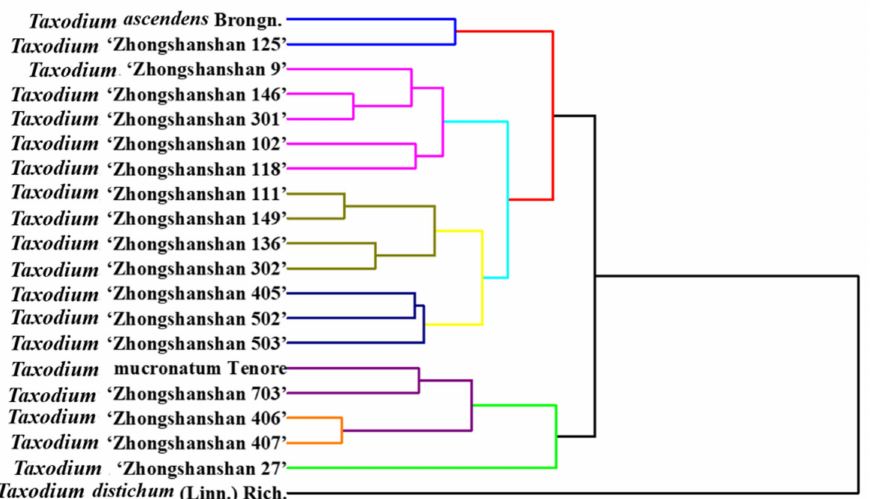
Figure 7. Dendrogram of T. ascendens , T. distichum , T. mucronatum , T. ‘Zhongshanshan 405’,